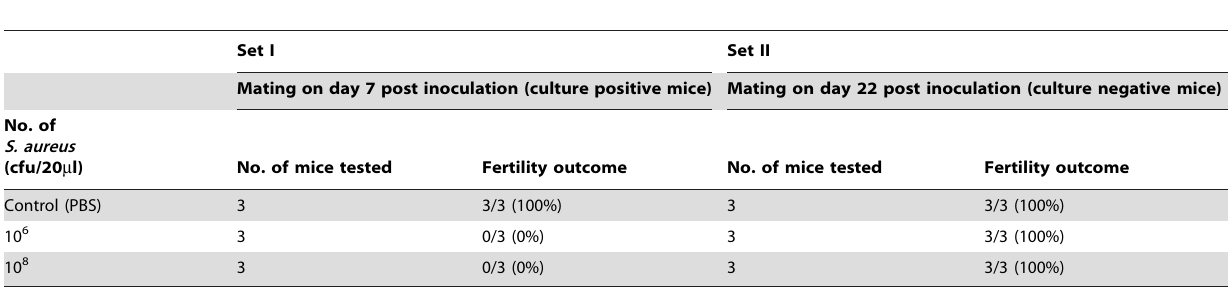
Figure 3. Histological examination of reproductive organs on day 26 after intravaginal administration of PBS (Control) or spermagglutinating strain of S.aureus for 10 consecutive days. Histology of the female reproductive tract on day 26 in mouse administered with PBS only (A, B, C) or with S. aureus (D, E, F) for 10 consecutive days. Control ovary (A) shows the persistence of corpus luteum (CL) and uterus (C) shows extensive proliferation of endometrium with formation of decidua (D, indicated by arrow). In S. aureus inoculated mice there is absence of corpus luteum in the ovary (D) and decidua in the uterus (E). Fallopian tubes in both the groups show normal histology (B & F). doi:10.1371/journal.pone.0052325.g003 Table 2. Effect of single intravaginal inoculation of spermagglutinating strain of S. aureus on fertility outcome in mice.